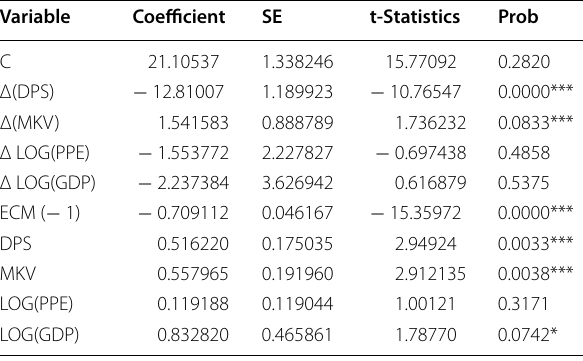
(PMG/ARDL: 1, 1, 1, 1,1). Dependent Variable: COR *, ***Indicates level of significance at 10% and 1%,